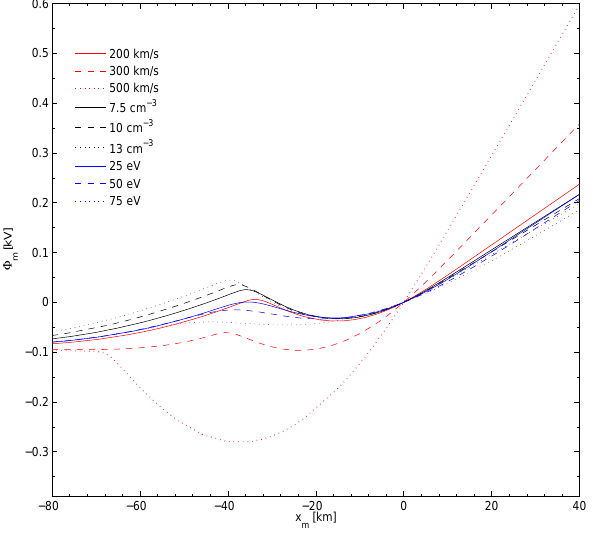
Fig. 4. Detail on the very central region of the magnetospheric elec- tron density profile, n(x m ) , derived for TD solutions obtained for various boundary conditions: three LLBL bulk velocities (red pro- files), three LLBL densities (black profiles), three LLBL electron temperatures (blue profiles). See also caption of Fig. 2. Table 1. Asymptotic values of the number density, temperature and bulk velocity of the asymptotic populations that define the TD tran- sition. “ − ” and “+” stand for electron and, respectively,